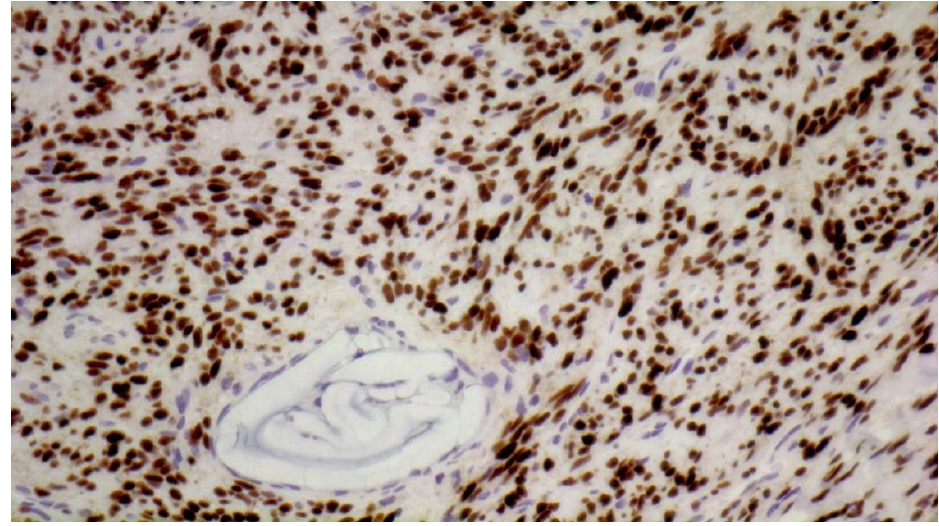
Figure 7. Tumor cells with strong diffuse positive reaction for CD34. Note an embolized vessel lined by CD34 positive endothelial cells (red arrow) as internal control (immunohistochemical stain, 10×).